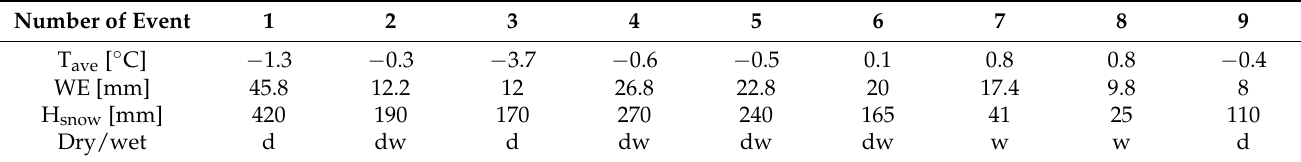
Table 4. Main meteorological parameters of the snowfall events (T ave : average temperature; WE: water equivalent; H snow : height of snow deposition on the